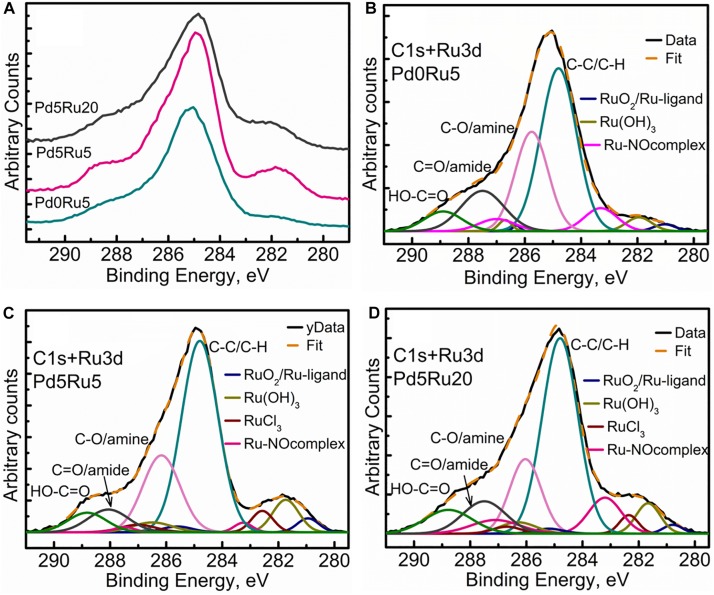
Carbon and Ruthenium XPS spectra showing (A) comparison of high resolution C 1s+Ru 3d region for all three samples, (B) C 1s+Ru 3d peak fitting for low Ru only sample, (C) C 1s+Ru 3d peak fitting for low Pd and low Ru loading sample, (D) C 1s+Ru 3d peak fitting for low Pd and high Ru loading sample.